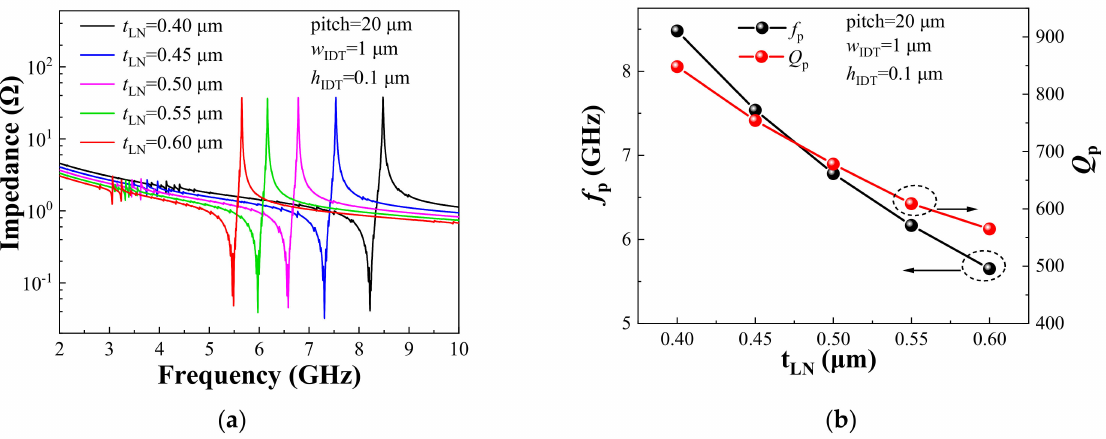
Figure 3. ( a ) Impedance curves of HF-LWRs with different t LN ; ( b ) Influences of t LN on f p and Q p